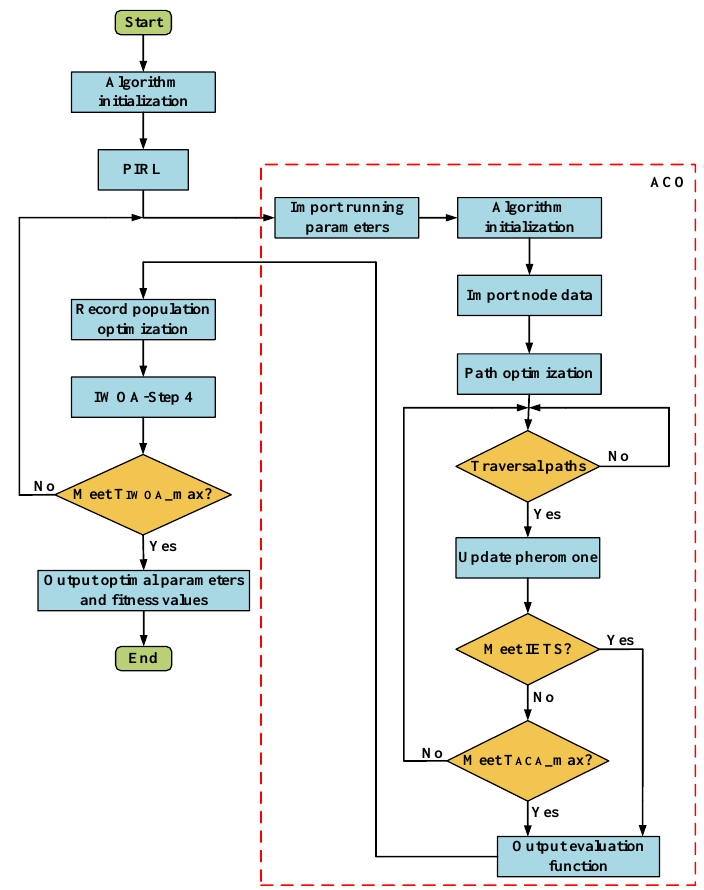
Figure 7. The flow chart of IWOA-ACO.